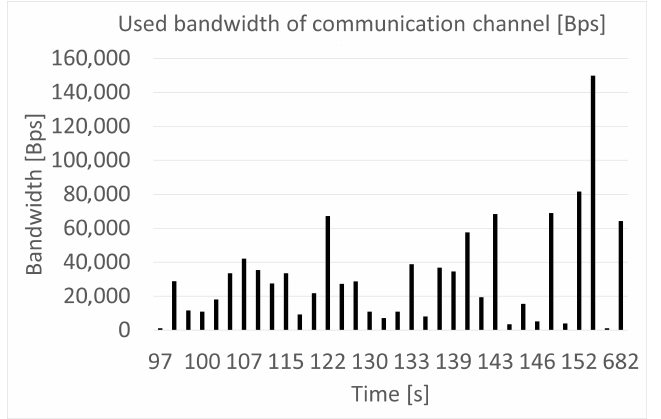
4 in every second of robotic system operation. The plot contains pl,km C